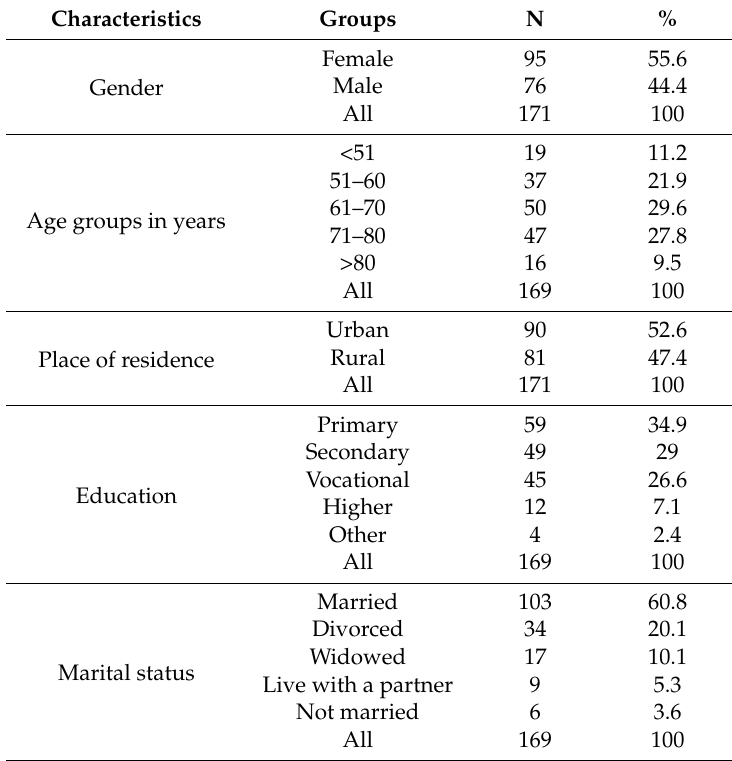
Table 1. Sociodemographic characteristics of